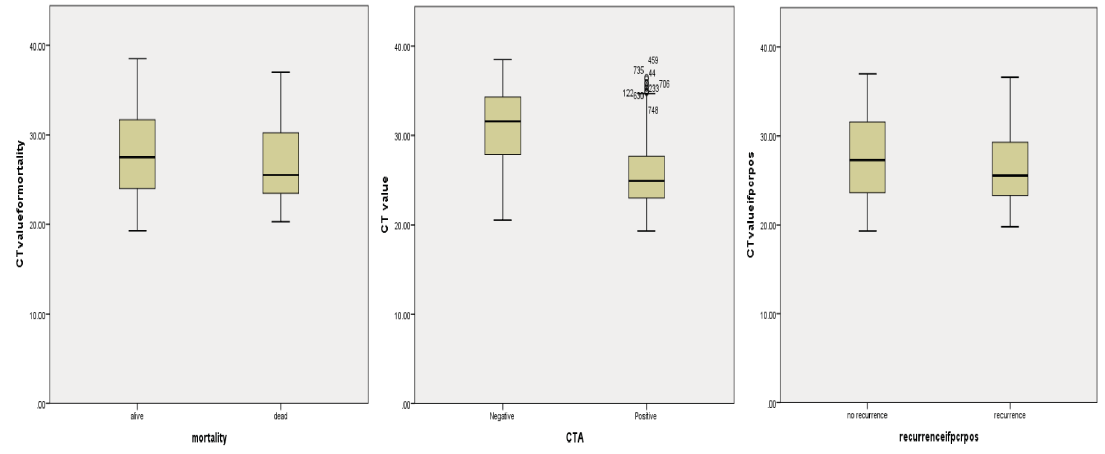
Fig 3. Boxplots of tgNAAT CT values. Boxplots of tgNAAT CT values against a) mortality b) CTA result and c) recurrence.